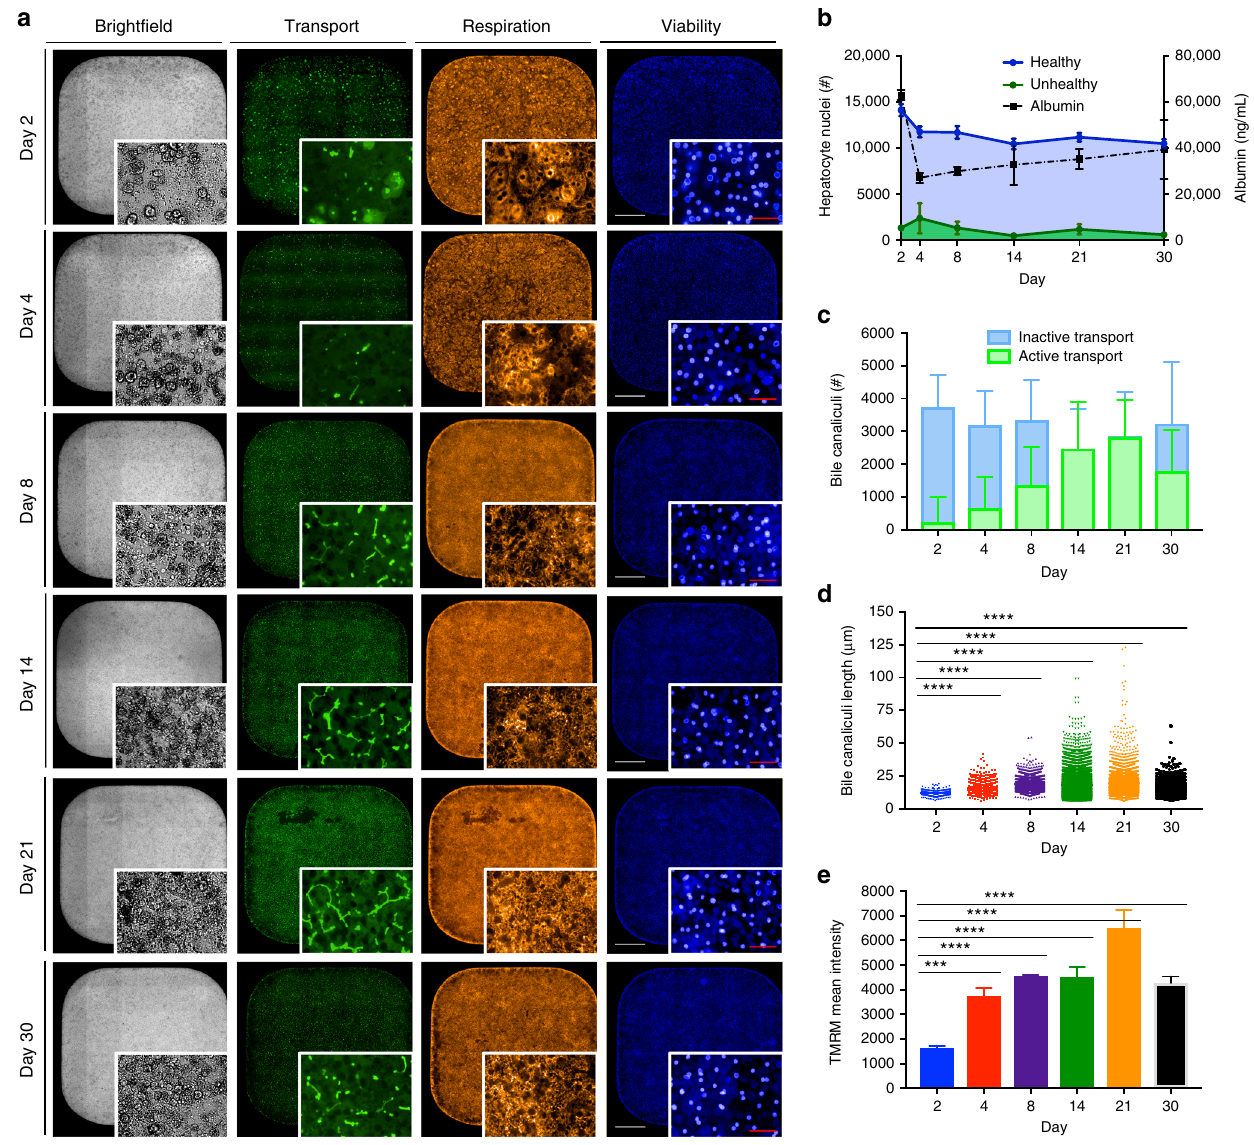
Fig. 2 Functional assessment of cultured primary human hepatocytes (PHHs). a Photometric measurements of live cellular functions (transport, respiration, and viability) were imaged on days 2, 4, 8, 14, 21, 30 post seed revealing PHHs cultured in a 384-well plate remain stable for 30 days. b Condition of hepatocyte monolayer was determined by nuclei morphology, size, and fl uorescence intensity, then classi fi ed as “ healthy ” and “ unhealthy ” . A steady adhered monolayer of ~11,000 PHHs and high albumin expression (ng ml − 1 ) persisted for the duration of 30 days. c , d Image analysis combining mean intensity of CellTracker TM Green CMFDA with differential imaging fi lters allowed for bile canaliculi quanti fi cation, assignment of active vs. inactive transport, and identi fi cation of bile duct length ( µ m) where peak measurements were revealed on day 21 post seed. e The mean intensity of the fl uorescent dye TMRM was used to measure mitochondrial activity with day 21 having the highest active mitochondrial sequestration. Graph bars represent means with s.d. for biological replicates ( n = 3) and experimental replicates ( n = 6, b , n = 3, c , e ) or individual values were plotted ( d ). Statistical signi fi cance was calculated using an one-way ANOVA with Dunnett ’ s multiple comparisons test to day 2 where statistical signi fi cance values are represented as P < 0.0001 (***) and P < 0.0001 (****). White scale bars represent 500 µ m and red represents 50 µ